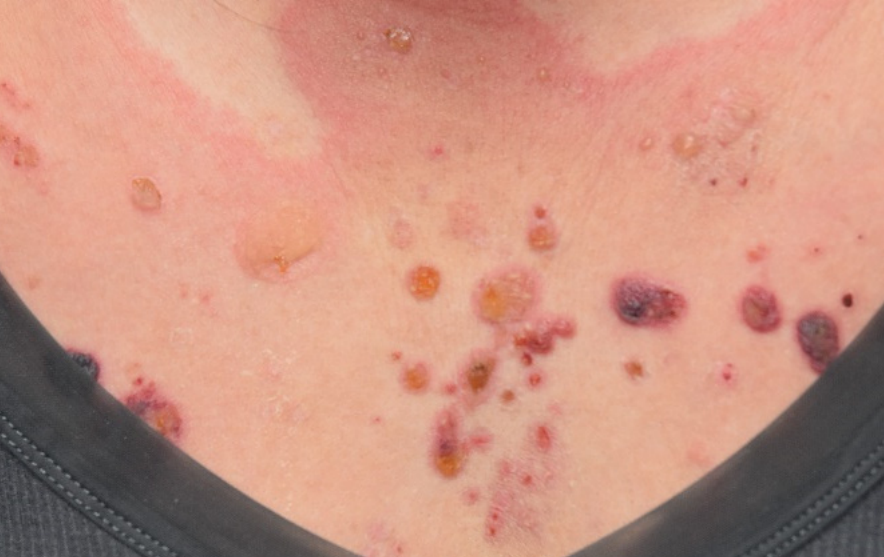
Figure 3. Bullous pemphigoid. Multiple pruritic tense bullae with erosions on the background of urticarial patches on the trunk and four extremities in a patient with metastatic lung cancer treated with nivolumab.